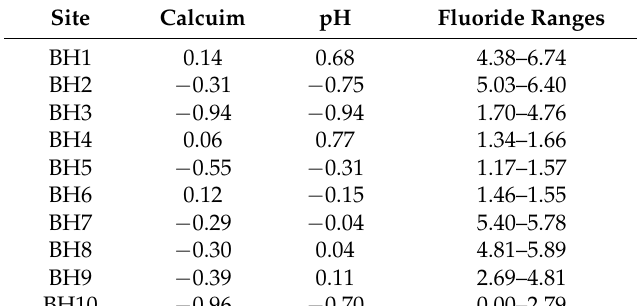
Table 4. Correlation of fluoride with calcium and pH.